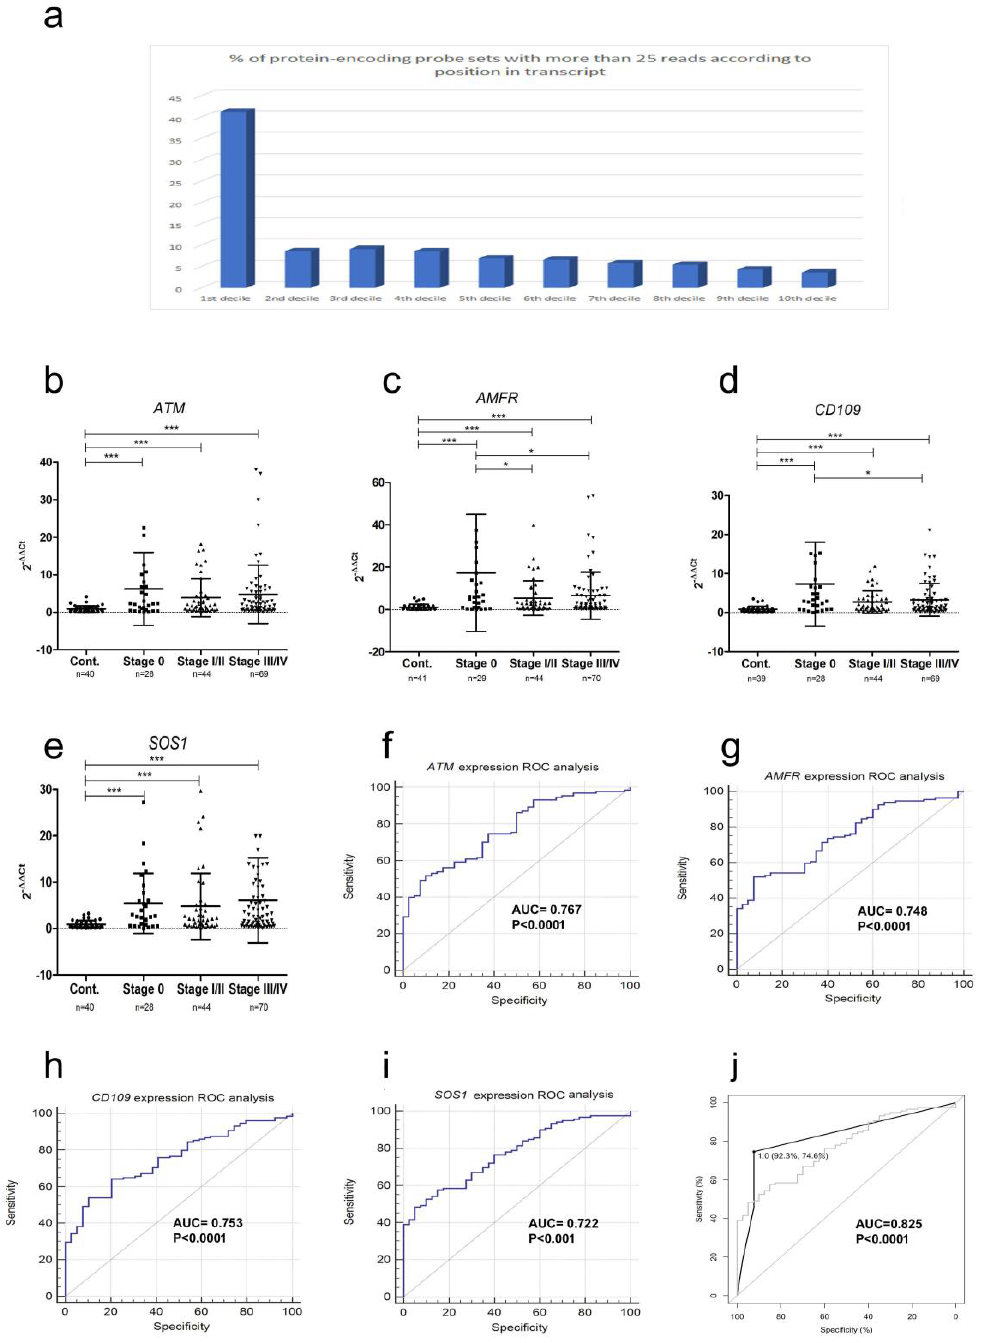
Figure 3. Expression levels of mRNA fragments measured by qRT-PCR in independent validation cohorts. ( a ) Proportions of probe sets containing at least 25 reads (>500 bases in length) relative to their position (5′ to 3′ direction) along the respective transcript. ( b – e ) Levels of ATM , AMFR , CD109 , and SOS1 probes were measured in a cohort of 185 plasma samples (41 controls and 144 melanoma patients). Levels are shown relative to the mean expression of the control sample cohort (i.e., 2−ΔΔ C t). Expression levels were compared using the Kruskal–Wallis multiple comparison test (all the mRNA fragments had p- values of <0.0001), and the Mann–Whitney independent t -test to carry out a pairwise comparison between groups (* p < 0.5; *** p < 0.001) ( f – i ) ROC analysis of mRNA probe expression levels as diagnostic biomarker (i.e., control vs. melanoma patient). ( j ) Panel ( ATM , AMFR , and SOS1 ) performance shown with black line, and SOS1 is shown as a gray line for comparison.